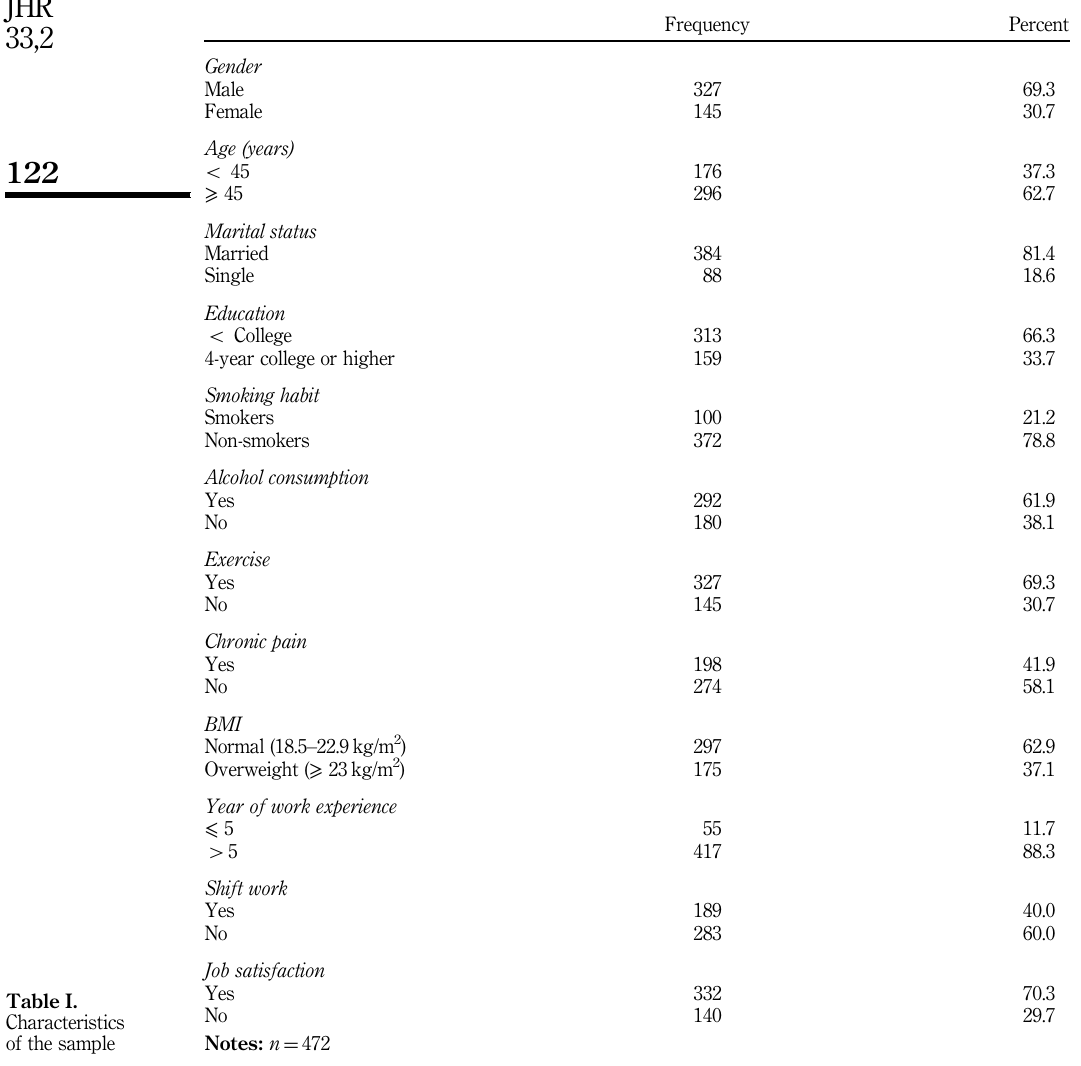
Table I. Characteristics of the